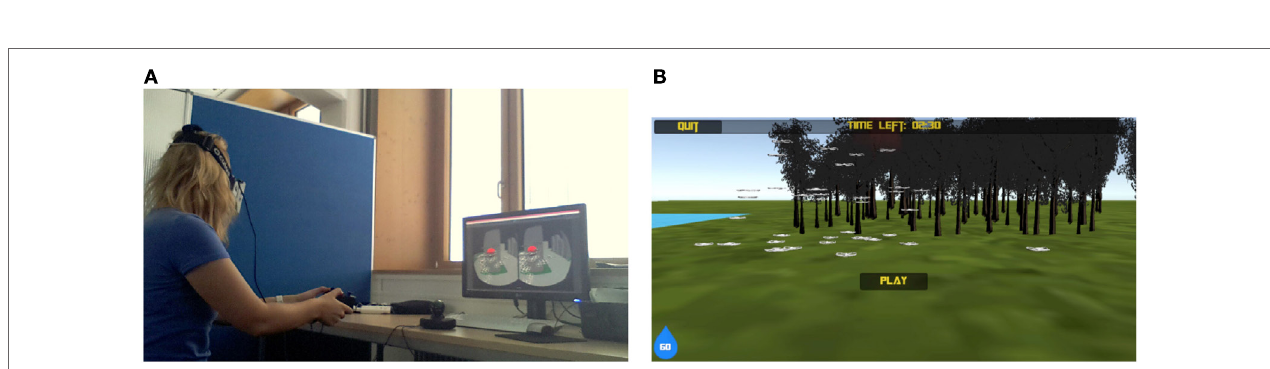
FigUre 11 | Ocbotics swarm modeled in Unity3D . The Unity3D environment allows us to integrate complex simulation models and immersive user interaction hardware such as motion-based input controllers and head-mounted displays. © 2014 IEEE. Reprinted, with permission, from von Mammen et al.